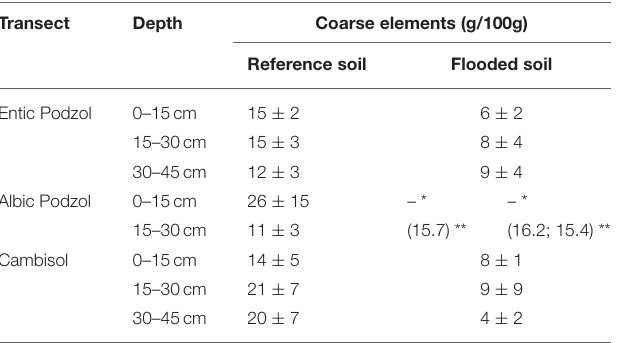
TABLE 3 | Average coarse element content in reference and drowned soils by depth for each transect.